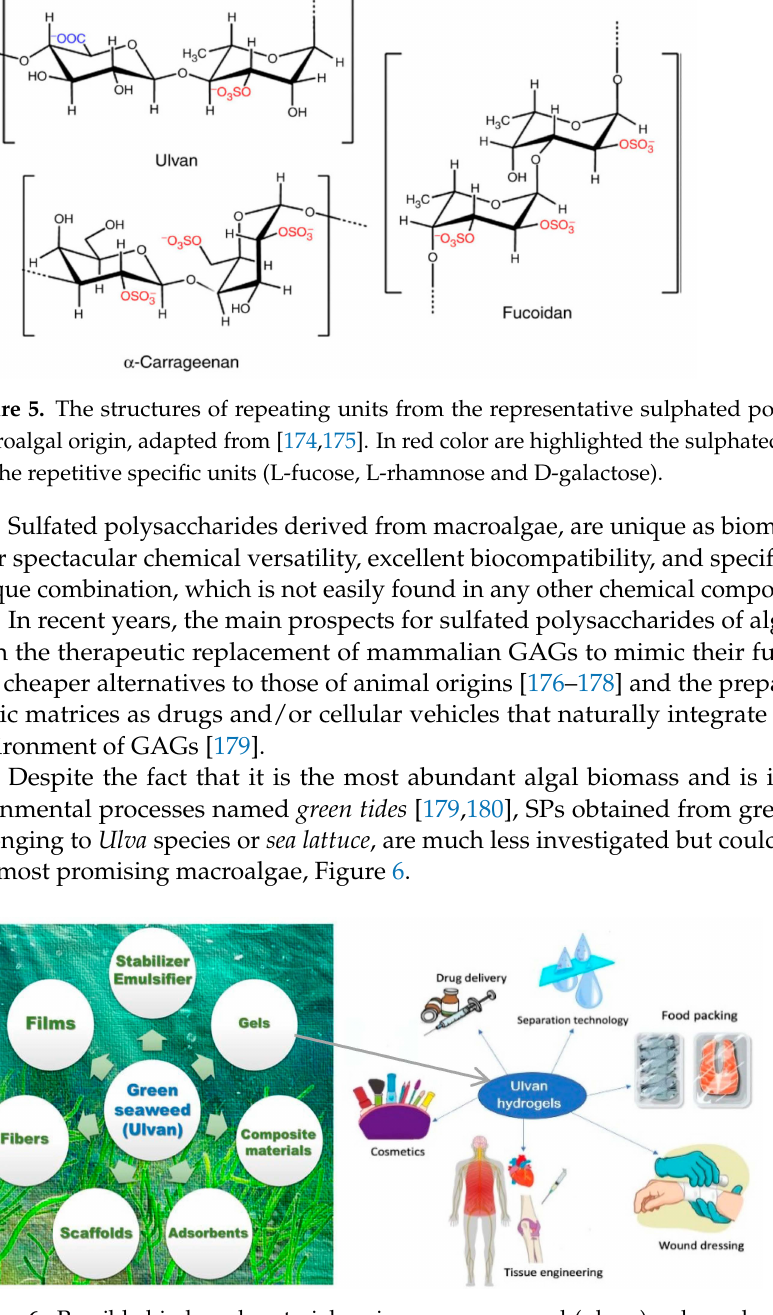
Figure 6. Possible bio-based materials using green seaweed (ulvan) polysaccharides, with some modifications, as a suitable source (adapted from